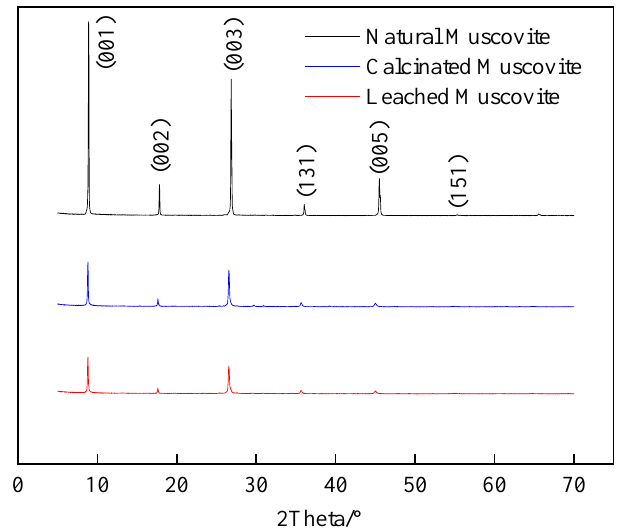
Figure 6. XRD patterns of natural, calcinated and leached muscovites: a pure muscovite (>99.9 wt%) is marked as “natural muscovite”, the muscovite calcinated at 900 ◦ C for 5 h is marked as “calcinated muscovite”, and the calcinated muscovite (2 g) is leached by H 2 SO 4 -NH 4 Cl solutions (0.3 mol/L H 2 SO4, 0.6 mol/L NH 4 Cl, 10 mL/g of L/S ratio) at 250 ◦ C for 4 h. The leaching residue is marked as “leached muscovite”.